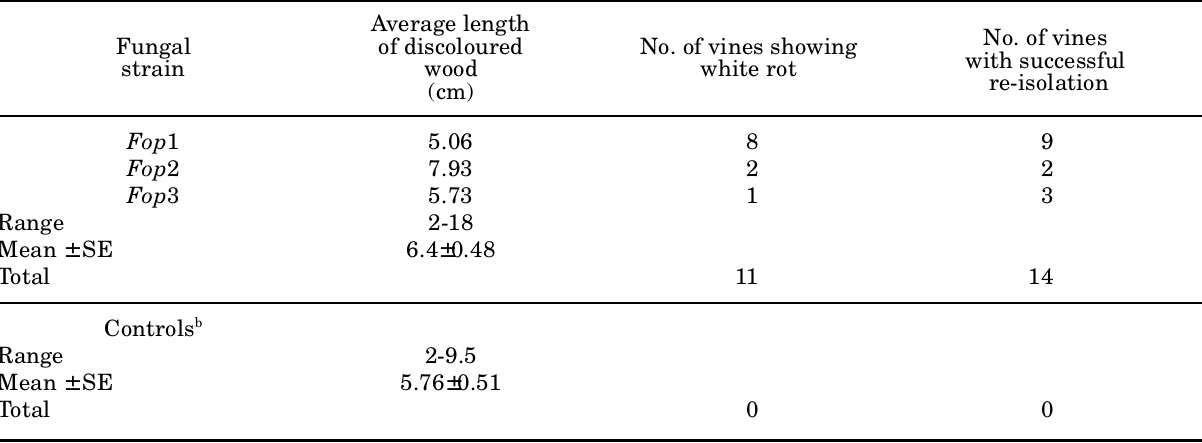
Table 1. Results of a two-year experiment with three strains of F. punctata inoculated on pruning spurs of 13-year- old grapevines cv. Sangiovese a .